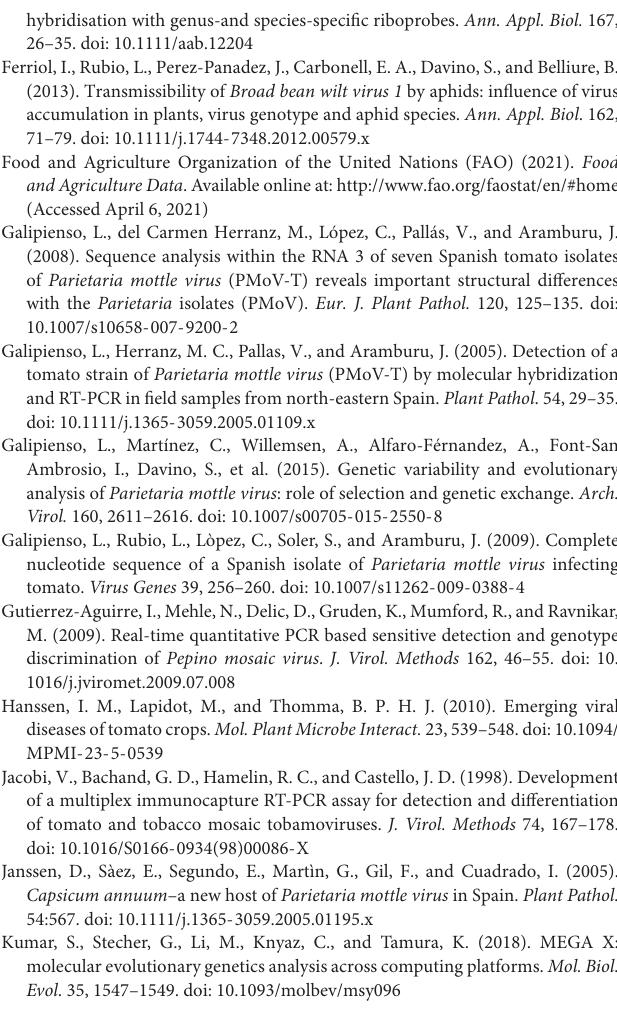
Supplementary Figure 1 | RT-qPCR assay with TaqMan R (cid:13) probe of fifteen characterized PMoV isolates and two RNA transcripts, using the PMoV21F/PMoV115R primer pair. Supplementary Figure 2 | Standard curves prepared with 10-fold serial dilutions of in vitro -synthesized RNA transcripts from PMoV ST-1 clone using RT-qPCR with TaqMan